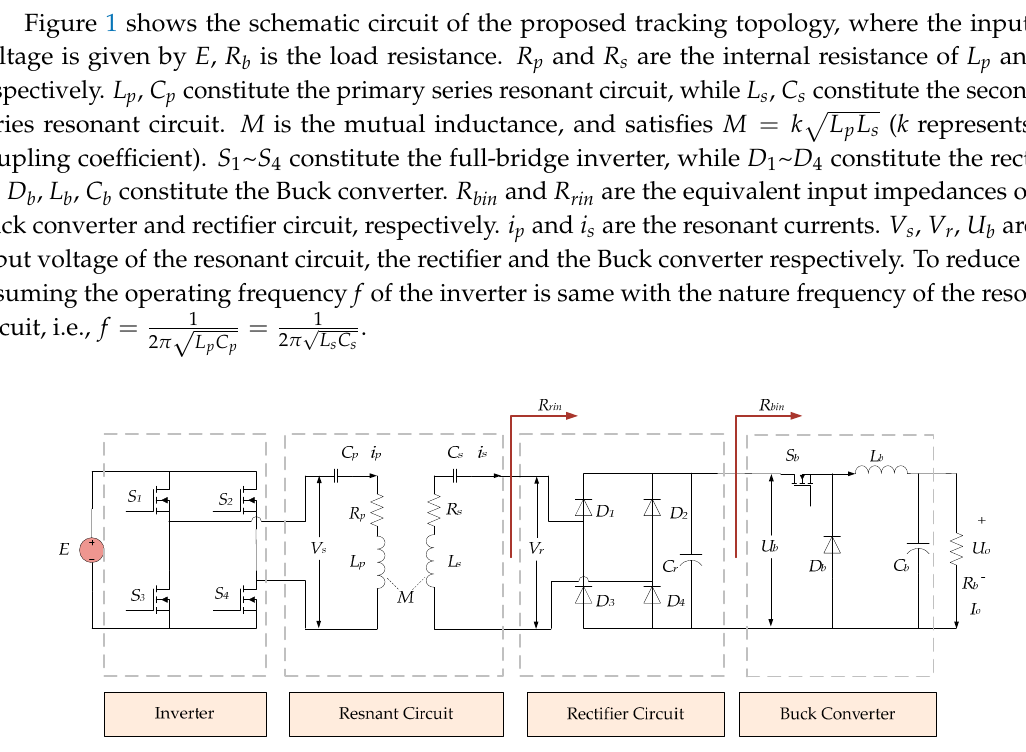
Figure 1. Schematic circuit of the tracking topology.